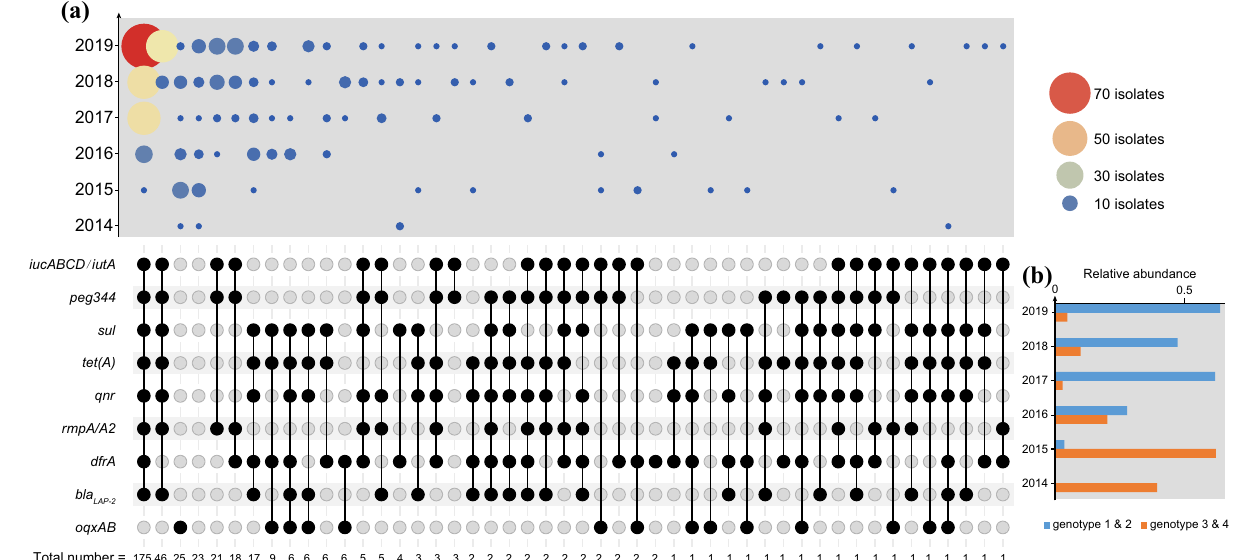
Fig. 6 | Temporal genotype trends in O2v1:KL64 from 2014 to 2019. a The combination matrix (bottom) depicts predicted genotypes of O2v1:KL64. Within the combination matrix, black circles indicate the presence of genes and the ver- tical combination of black circles represents the genotype. The total number of each genotype is indicated below the matrix. The combination matrix was created